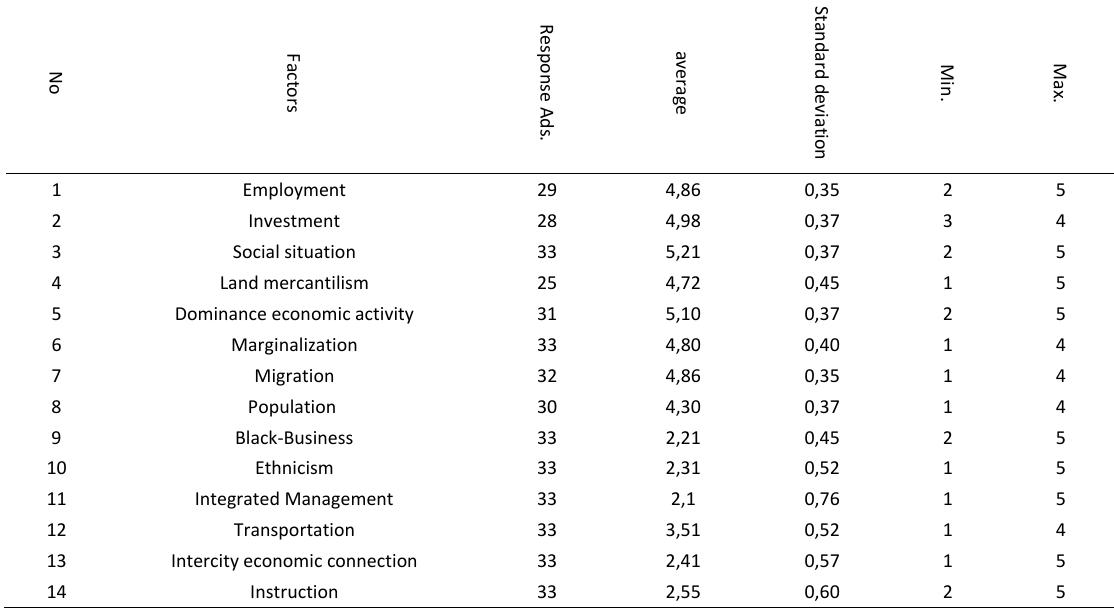
Table 3: Stage 1 of the Delphi method in developing indicators determining the mechanisms affecting urban development, taking into account its sphere of influence